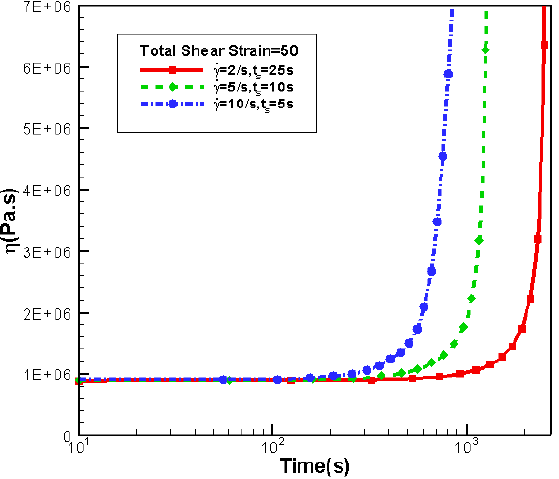
Figure 12. Evolution of viscosity with same shear strain but different shear rate and shear time.